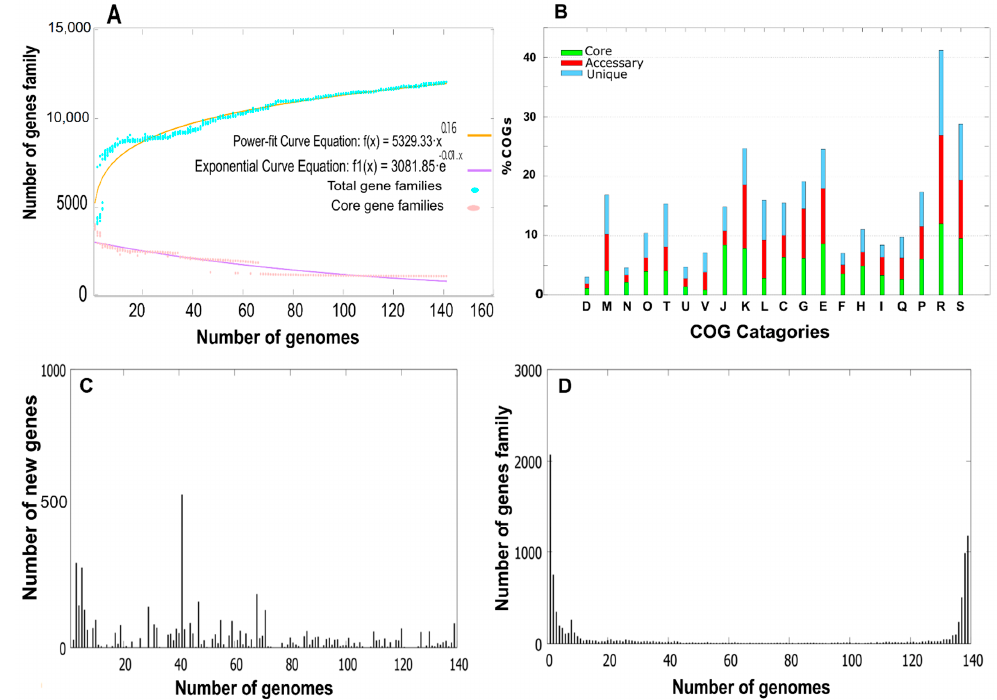
Figure 5. Mathematical extrapolation of the pan-core genome of 139 B. subtilis strains: ( A ) The core-pan genome curve; ( B ) COG distribution in the core genome, accessory, and unique genome pool. D, Cell division; M, Cell wall/membrane biosynthesis; N, Cell motility; O, post translational modifications; T, signal transduction, U, Intracellular trafficking and transport; V, Defense; J, Translation; K, Transcription; L, Replication and repair; C, Energy production; G, Corbohydrate metabolism and transport; E, Aminoacid metabolism and transport; F, Nucleotide metabolism and transport; H, Coenzyme metabolism and transport; I, Lipid metabolism and transport; Q, Secondary metabolites biosynthesis; P, Inorganisc ions metabolism and transport; R, General function prediction only; S, Function unknown; ( C ) addition of new genes to each genome; ( D ) distribution of gene families.